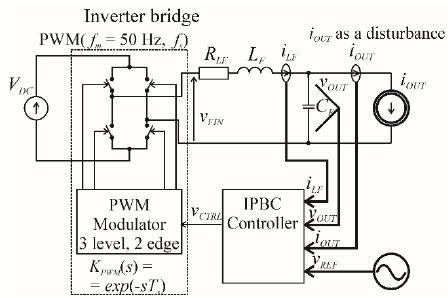
Figure 1. Simplified concept of a MISO control in inverters.